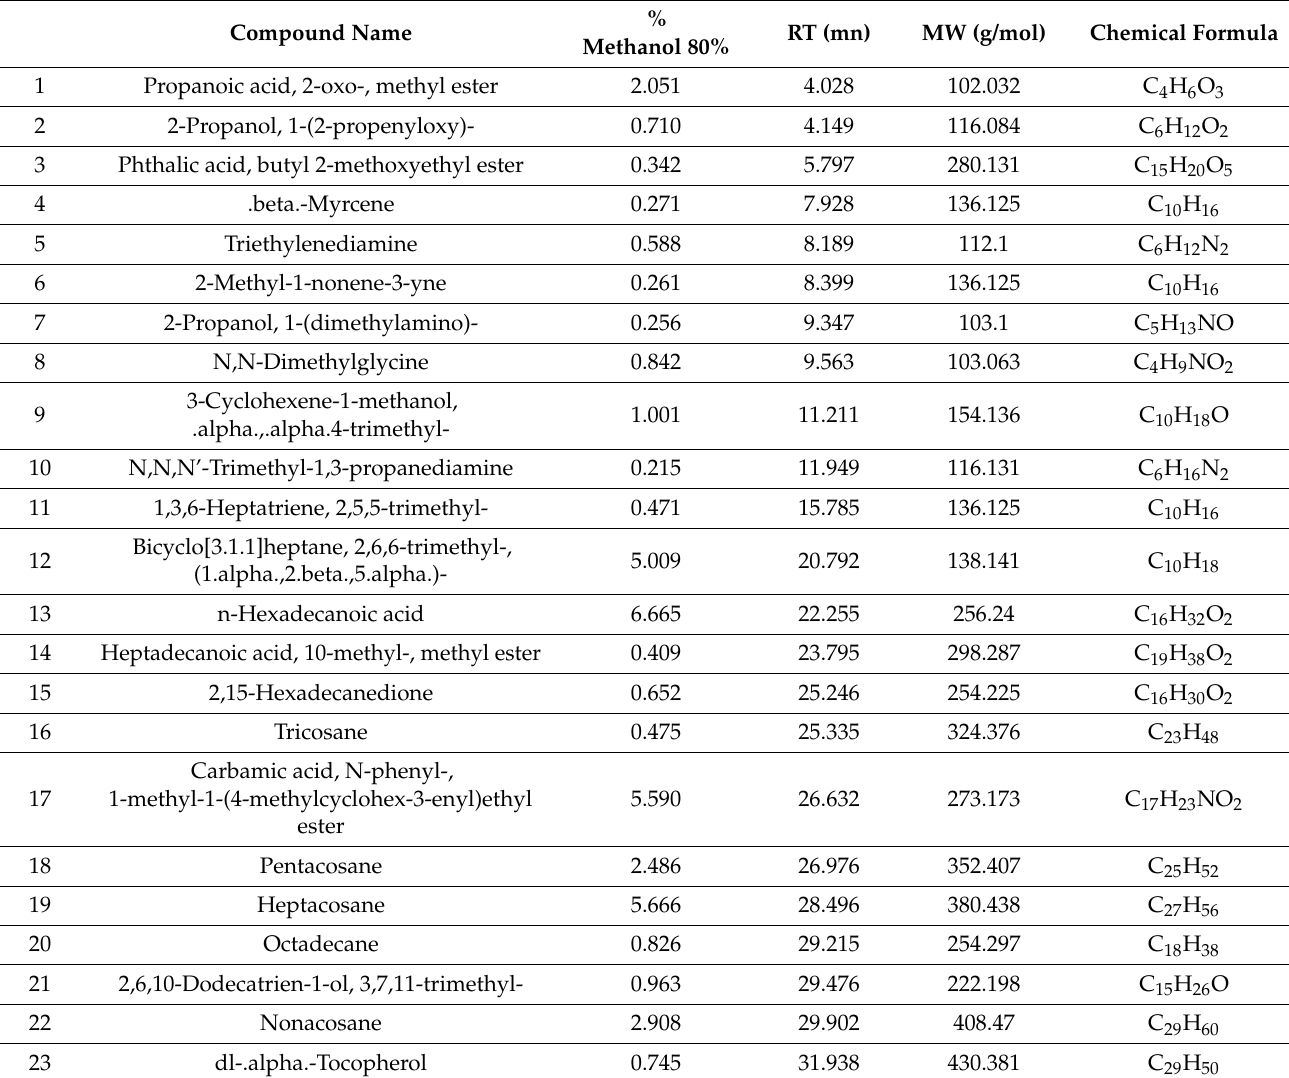
Table 2. Chemical composition of the compounds that are present only in the methanol 80 % R. epapposum extracts.